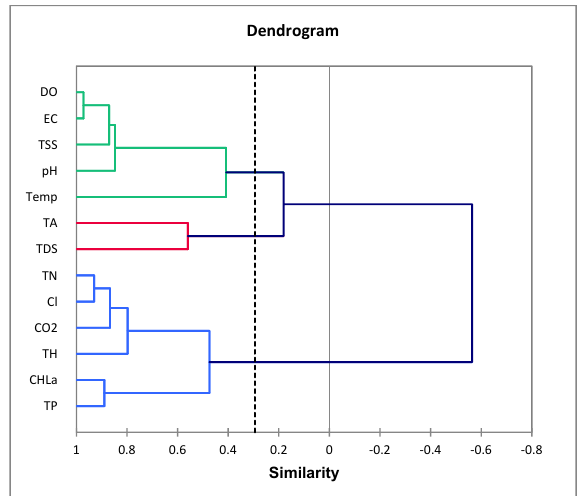
TSSECDO TPCHLaTHCO2ClTNTDSTATemppH Fig. 6: Dendrogram with clustering results for the physicochemical Fig. 6: Dendrogram with clustering results for the physicochemical parameters in Khacheopalri lake water parameters in Khacheopalri lake